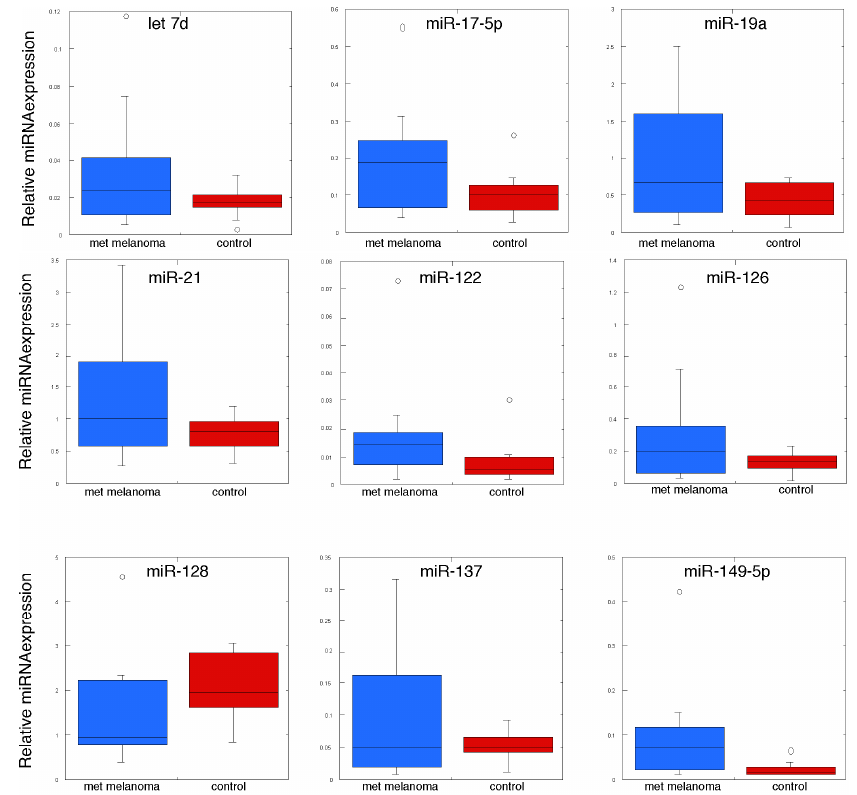
Figure 3. MiRNA expression in plasma ‐ derived exosomes from individuals with metastatic melanoma and normal volunteers. RNA was prepared from plasma ‐ derived exosomes from individuals with metastatic melanoma and normal volunteers. MiRNA expression was determined by qPCR ( n = 3) and normalized to the spiked ‐ in levels of Cel39.